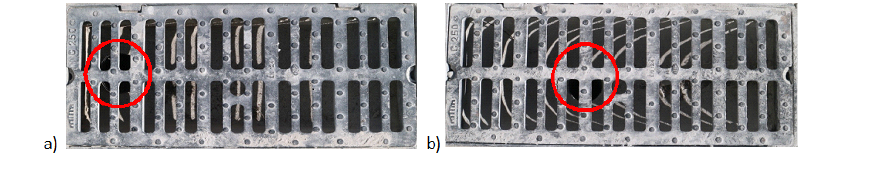
Figure 1. Two up-views of two different typical gullies with different location of the gully outlet (connection to the pipe system): ( a ) upstream; ( b ) near center (red circles indicate the gully outlet